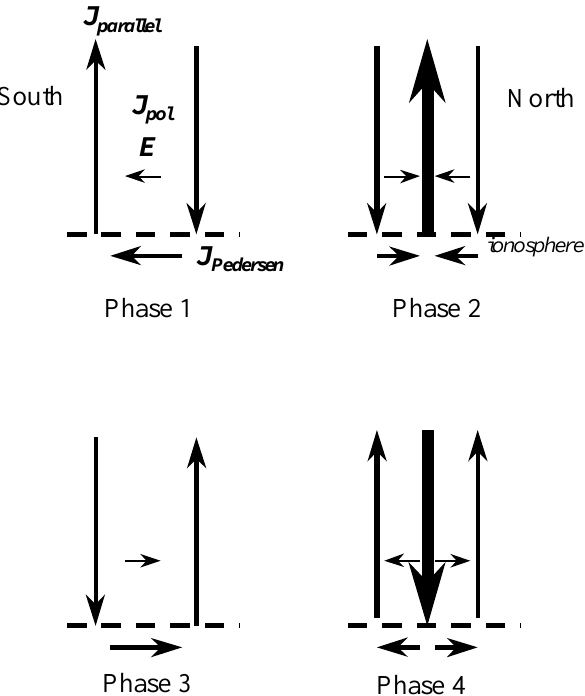
Fig. 2. A schematic of currents and fields in field line resonances near the ionosphere, shown in phases 90 degrees